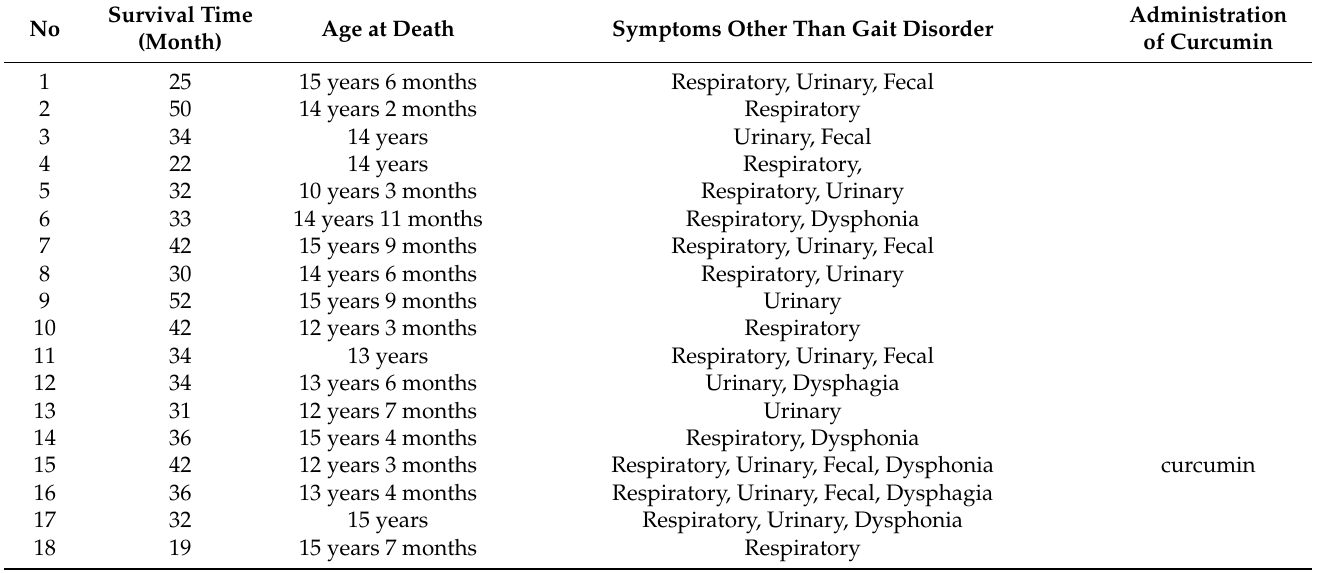
Table A1. Details of clinical symptoms and treatment for each